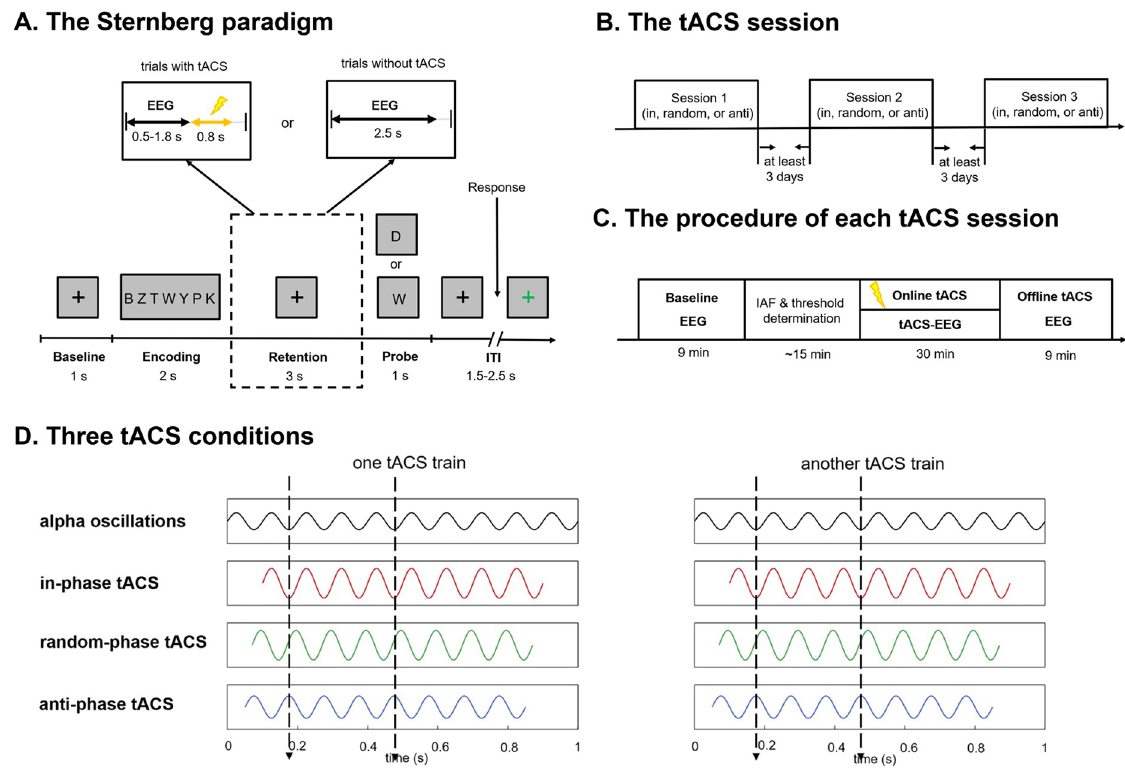
Fig 3. The designs of Experiment 1. ( A ) Schematic representation of the modified Sternberg paradigm used in this study. For each trial, participants were shown a list of 7 consonants and were asked to indicate (by button press) whether the probe was part of the memory list. For trials with tACS application, EEG recording started from the onset of the retention subprocess, and stopped once tACS was triggered; for trials where tACS was not triggered, EEG recording lasted for 2.5 s since the beginning of the retention subprocess. ( B ) Participants completed 3 tACS sessions of different conditions (in-phase tACS, random-phase tACS, or anti-phase tACS). The order of the tACS conditions was counterbalanced across participants, and the 3 sessions of each participant were all separated by at least 3 days. ( C ) Experimental procedure for each session. Within each session, participants first completed 60 trials of the Sternberg task with EEG recorded during the retention subprocesses (“Baseline”). Subsequently, the IAF of this session was calculated using the Baseline EEG data. Then, 180 tACS-EEG trials of the Sternberg task were performed with tACS delivered specifically during the retention subprocesses (“Online tACS”). After Online tACS, participants completed 60 trials of the Sternberg task, while EEG data were recorded during the retention subprocesses (“Offline tACS”). ( D ) tACS was delivered in 3 different conditions: (1) in the in-phase condition, tACS was applied at the IAF with 0˚ relative phase to the endogenous alpha oscillations; (2) in the anti-phase condition, tACS was applied at the IAF with 180˚ relative phase to the endogenous alpha oscillations; and (3) in the random-phase condition, no phase alignment between the delivered tACS and the detected endogenous alpha oscillations was used, with the phase differences changing from 0˚ to 360˚ across trials. For all conditions, the onset phase of the sine-wave tACS waveform was invariably 0˚. The illustrative waveforms in the figure do not represent the actual sizes. EEG, electroencephalogram; IAF, individual alpha frequency; tACS, transcranial alternating current